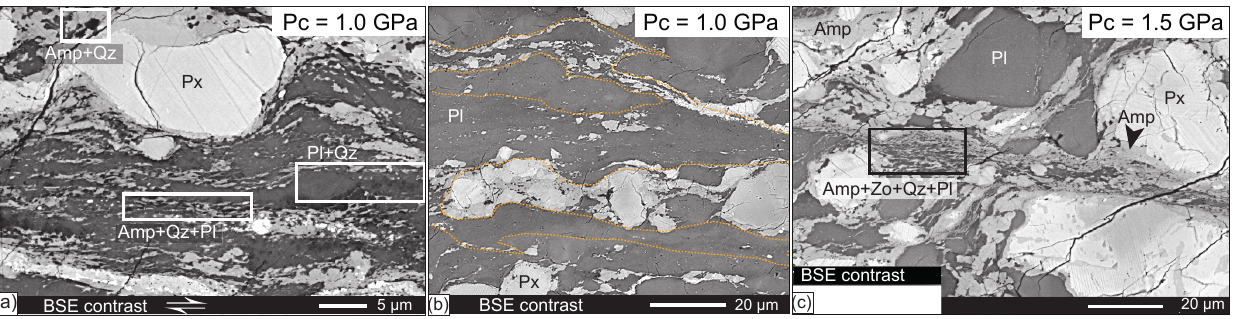
Figure 6. Distribution of phases in Maryland diabase. (a) Area of extensive phase mixing in a shear band: mixing of Pl + Qz, Pl + Zo, and Amp + Qz. Mixing between Amp and Pl is less frequent. Px clasts show Amp coronas and asymmetric Amp tails. (b) Area where shear bands (outlined with dashed orange lines) are predominantly composed of polycrystalline Pl. (c) Extensive phase mixing between Amp + Zo + Qz( + Pl) within shear bands. Px clasts show Amp coronas and asymmetric Amp